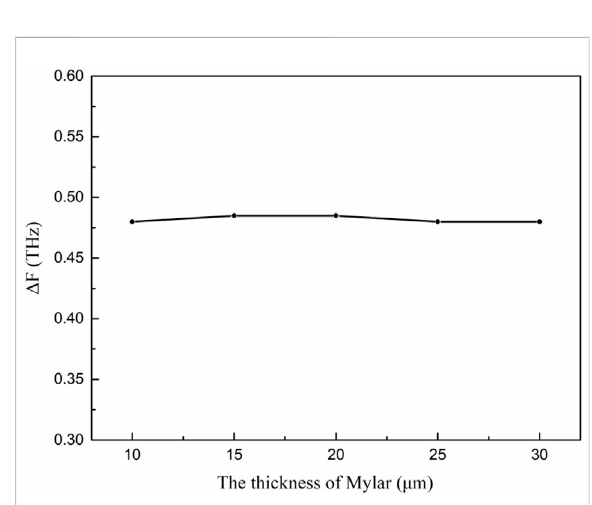
FIGURE 5 The Δ F of the THz transmission spectrum of THz-DS with the different thickness of